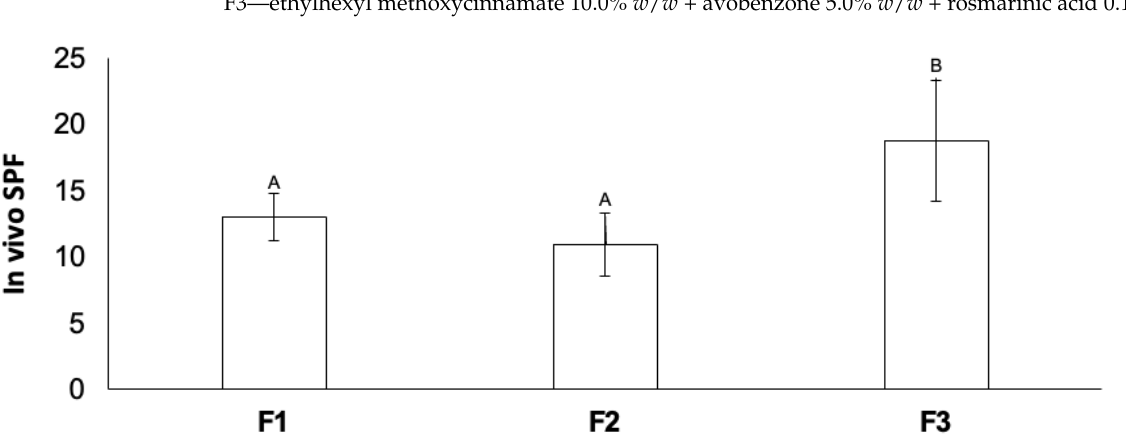
Figure 2. Photostability test. ( A ) In vitro sun protection factor (SPF) before and after irradiation; ( B ) critical wavelength (nm) before and after irradiation. Samples that share a letter are statistically equal (Tukey test: p ≤ 0.05). No irradiation (t0), 30 min irradiation (t30), 60 min irradiation (t60), and 120 min irradiation (t120). F1 — ethylhexyl methoxycinnamate 10.0% w / w + avobenzone 5.0% w / w ;